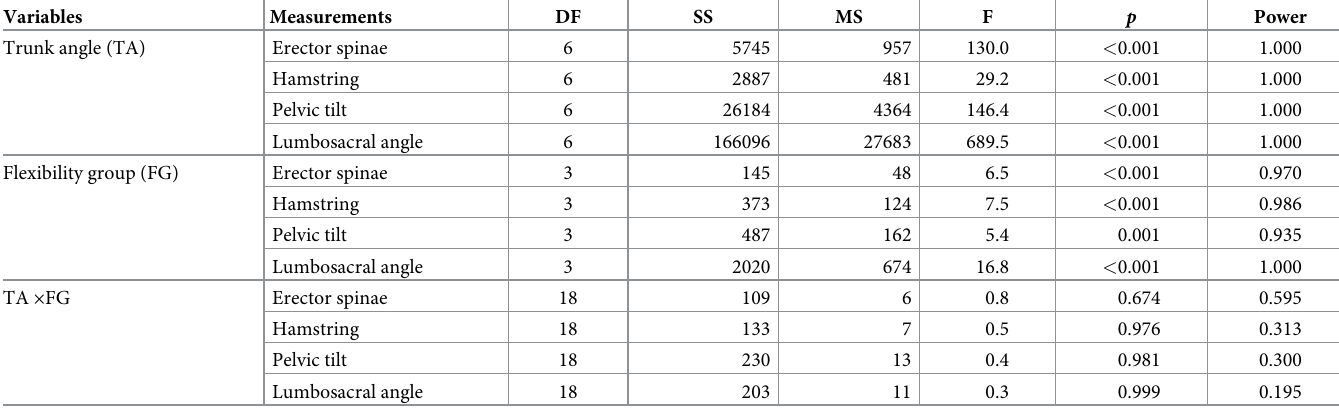
Table 2. Two-way ANOVA results of the